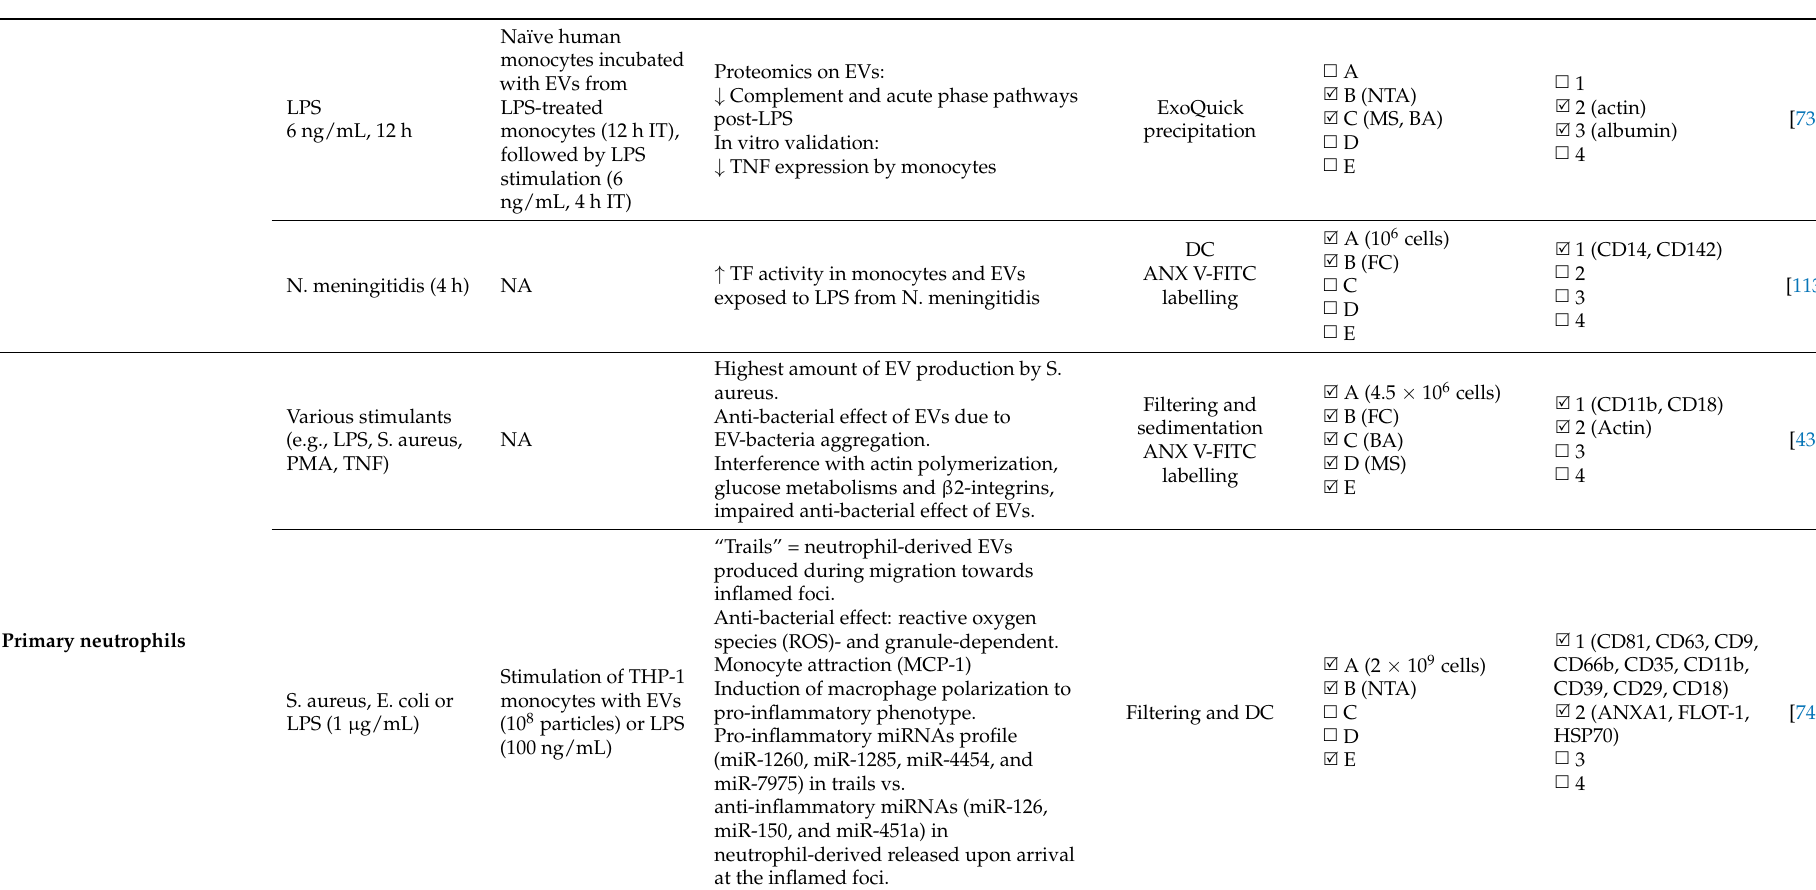
Rabbit-derived heart preparations incubated EV-induced nitric oxide production. with EVs (0.5 to 1× EV Induction of myocardial amount in plasma)